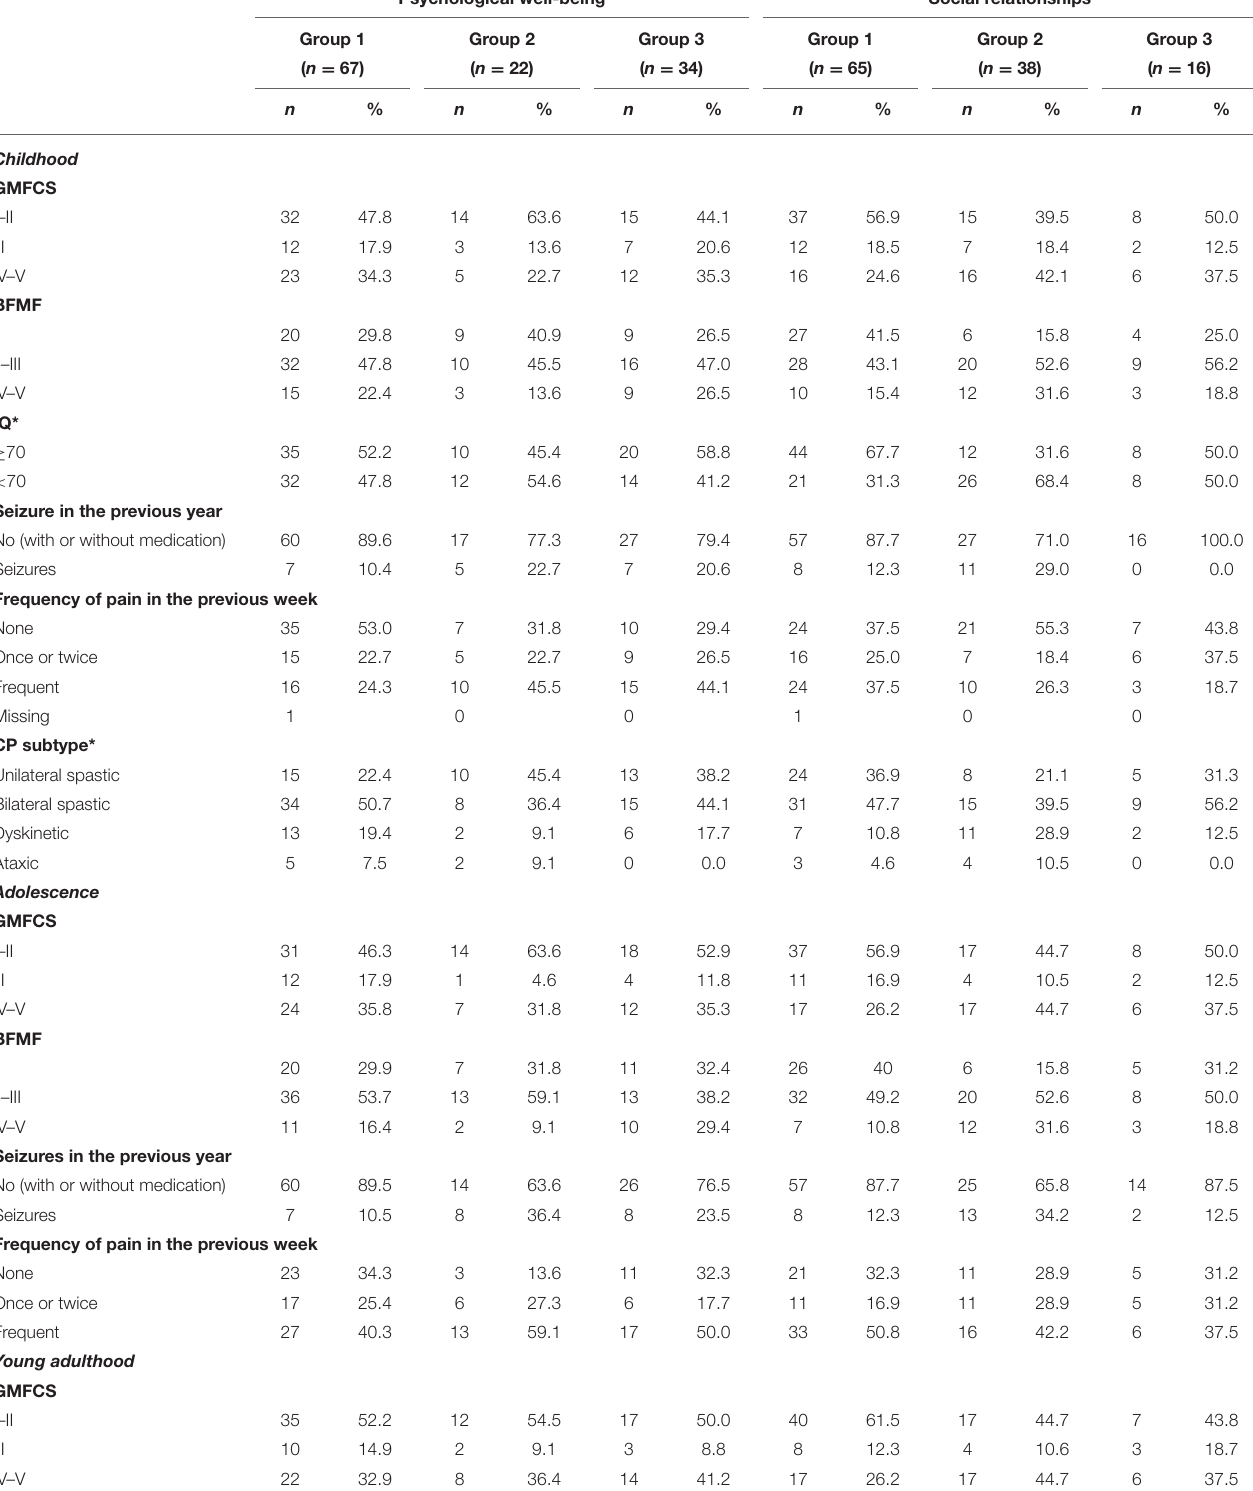
TABLE 5 | Distribution of impairment severity, pain, and seizure problems from childhood to young adulthood by identified QoL trajectories in individuals with CP: SPARCLE cohort—France, Germany, Italy, and Sweden. Psychological well-being Social